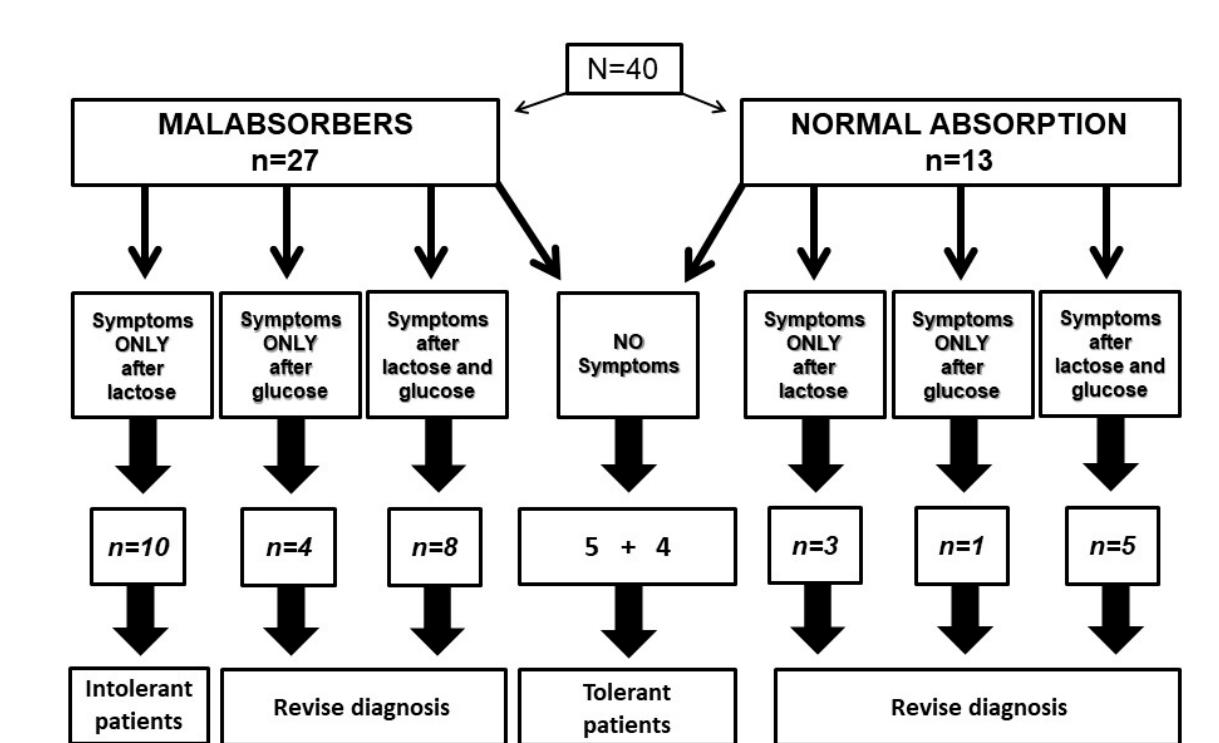
Figure 4. Results of blinded lactose and glucose breath tests in 40 patients self-reporting lactose intolerance.